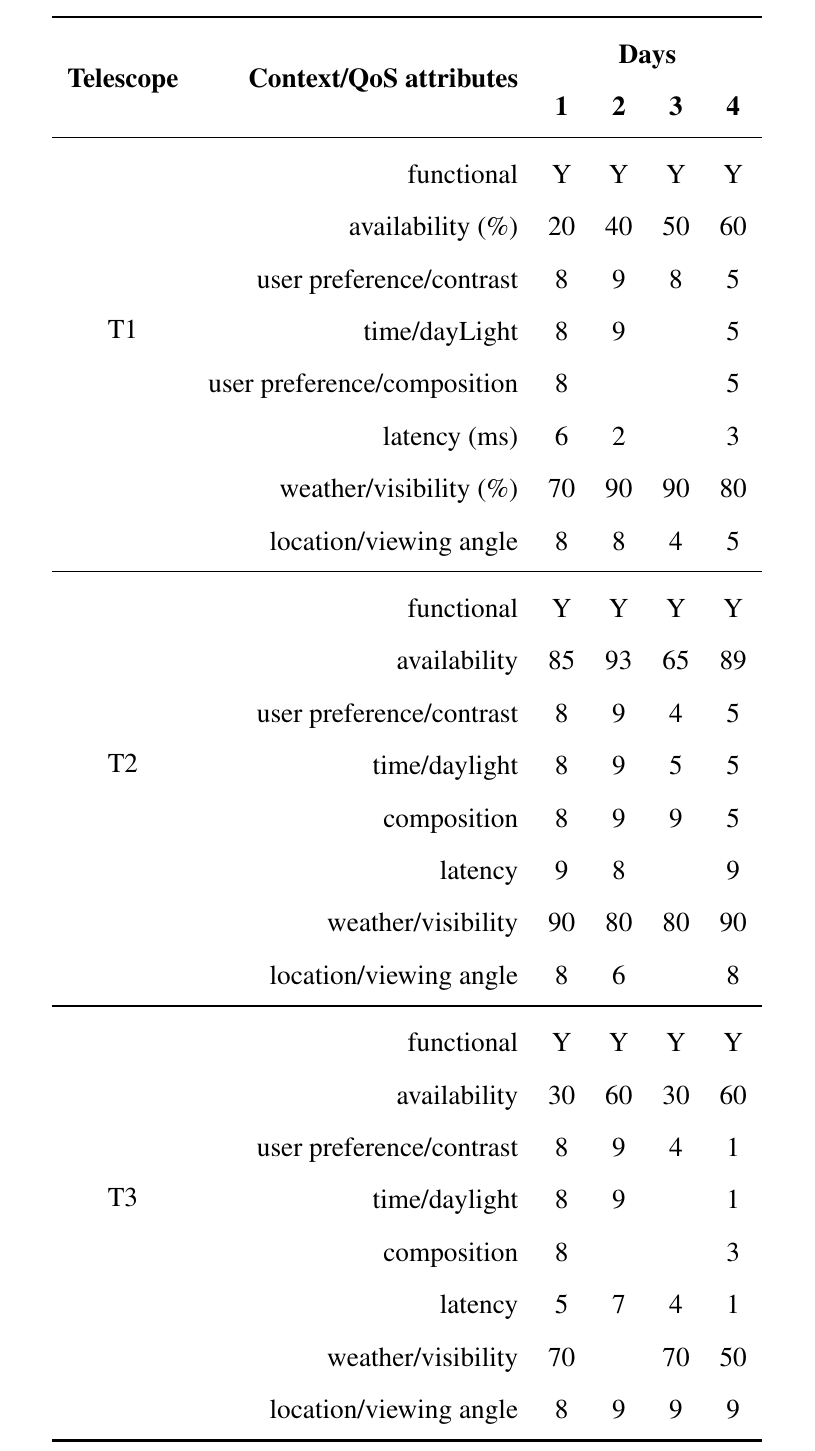
Table 1. An example set of telescope web services with multiple dynamic QoS attributes, as measured on four consecutive days. Y,